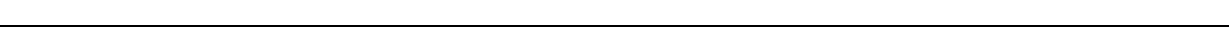
Fig. 8 HDAC1 deacetylates SRSF5 upon low glucose. a HDAC1 overexpression speci fi cally decreases SRSF5 acetylation. HEK293T cells were